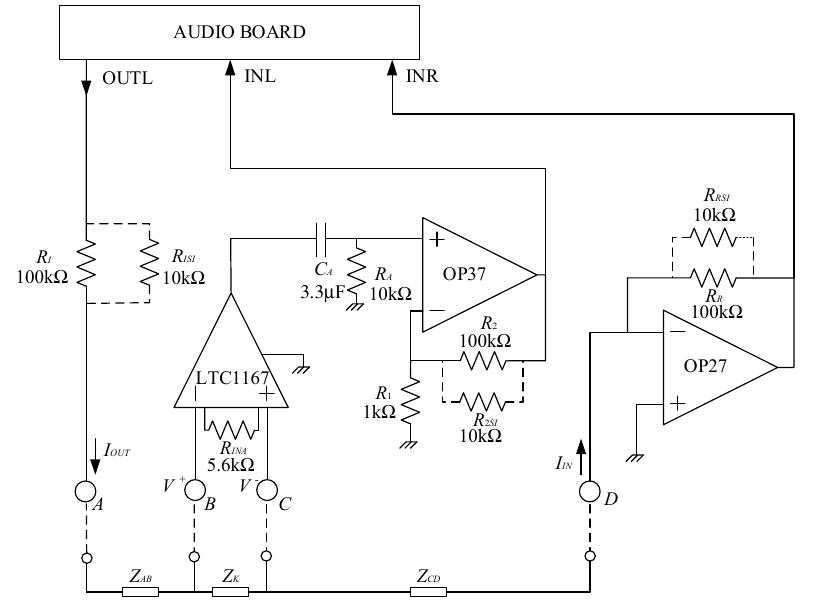
Figure 1. Circuit schematic of the proposed system. Z K is the impedance of the knee, and Z AB and Z CD are the parasitic impedances between electrodes A and B and C and D, respectively.